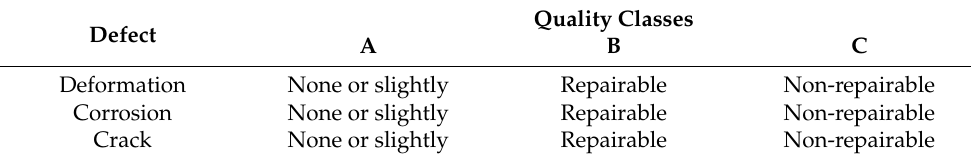
Table 4. Quality classification for reused scaffolds.